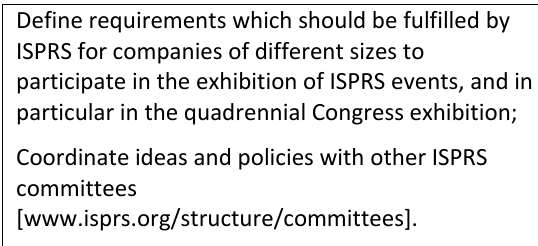
Table 4: Five core ideas for the I2AC in the words of the ISPRS Secretary General